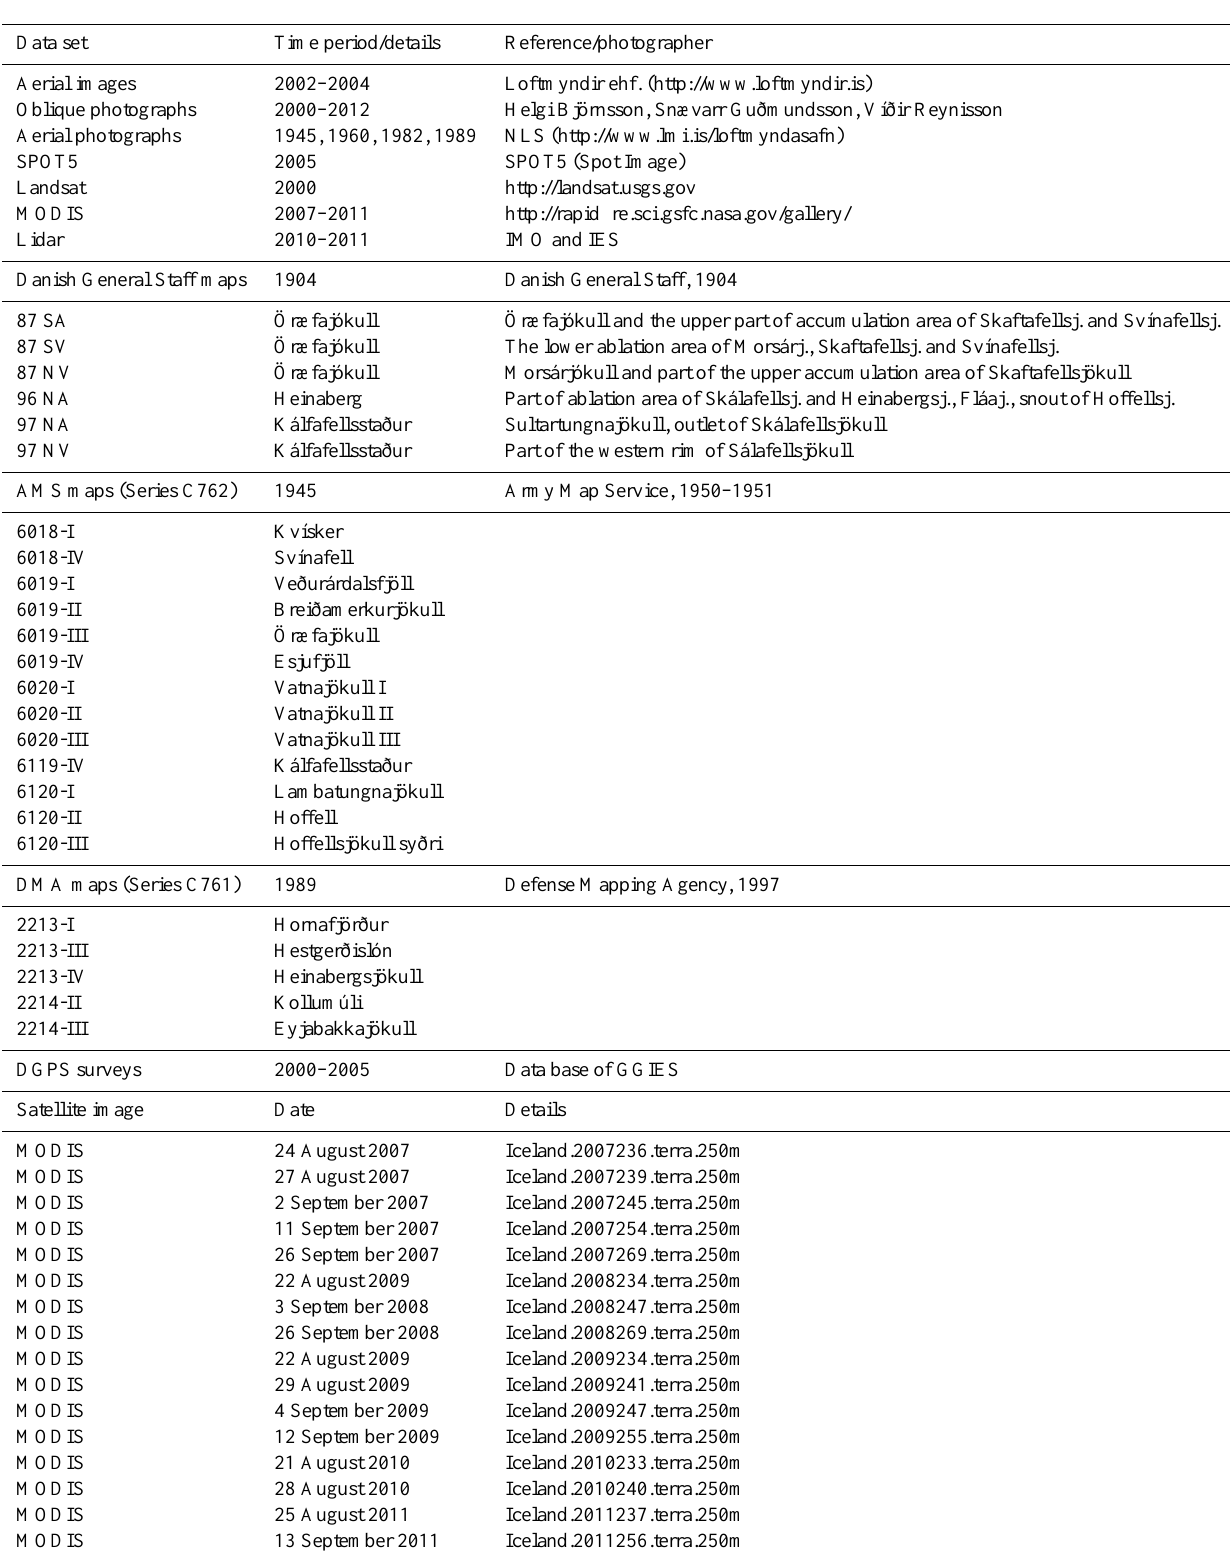
Table 2. Overview of the data sets used to delineate the glacier margin, create DEMs, MODIS images to extract the late summer snowline (proxy for the